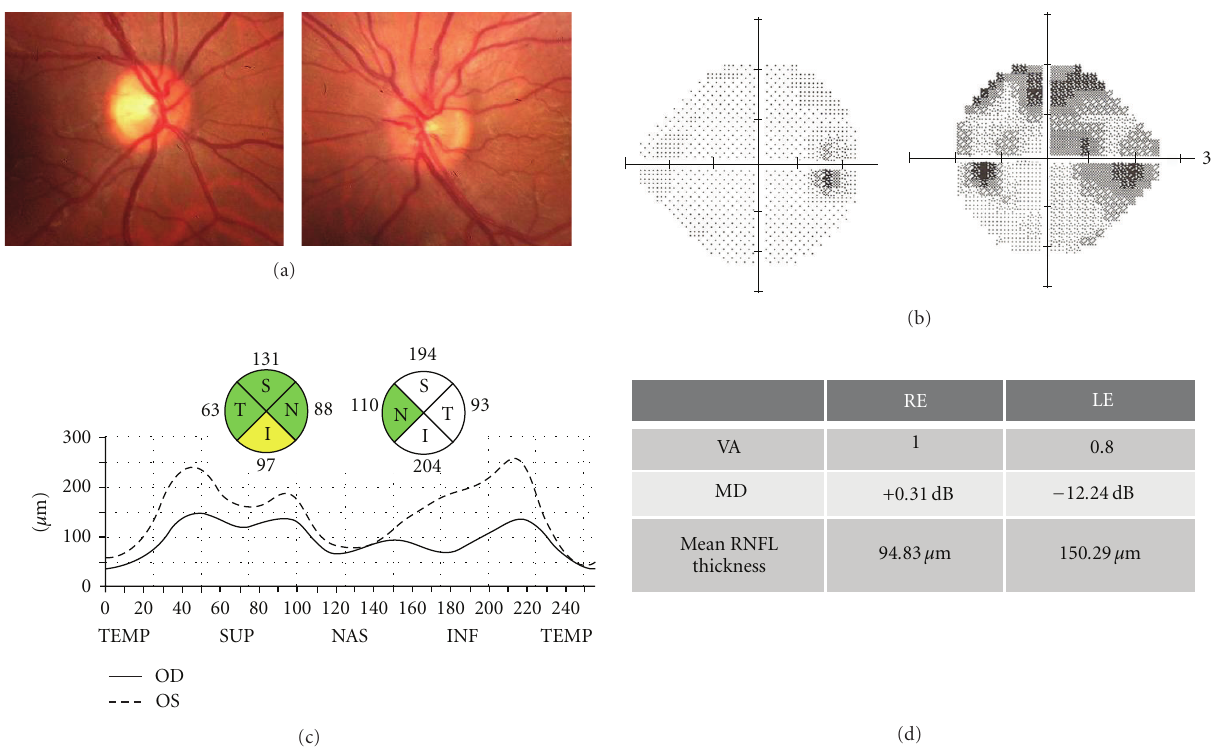
Figure 1: Fundus photograph, visual fields, and optical coherence tomography of a 30-year-old man who consulted due to ocular pain and visual loss in his left eye for two weeks. Optical coherence tomography shows an increased retinal nerve fiber layer thickness in his left eye due to optic nerve